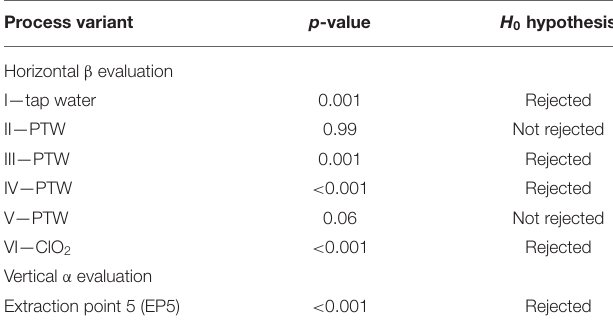
TABLE 8 | Statistical evaluation of storage day 7.